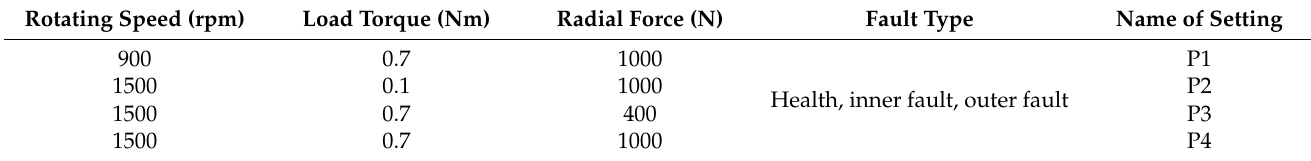
Table 3. Working conditions settings of Paderborn dataset.